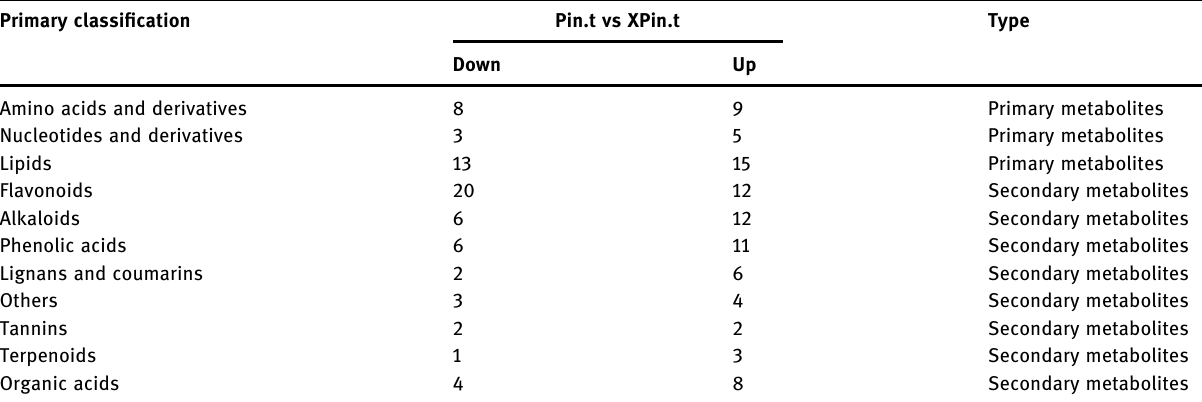
Table 2: Statistics of the DAM between Pin.t and XPin.t Primary classi fi cation